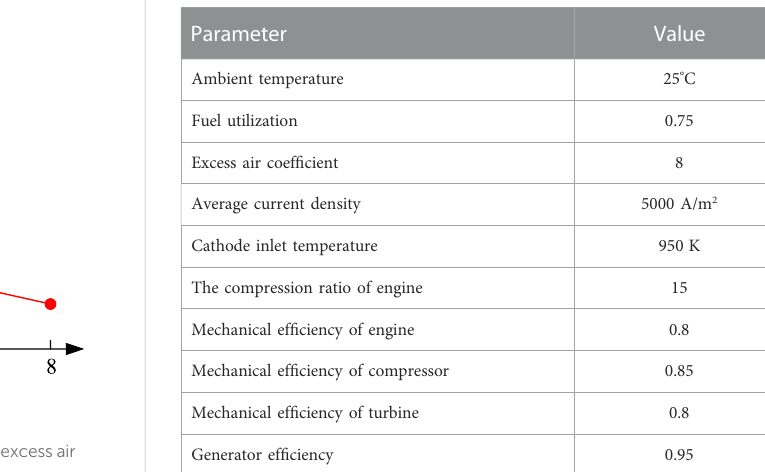
TABLE 4 Hybrid power system parameters (Liu et al., 2021), (Park et al.,